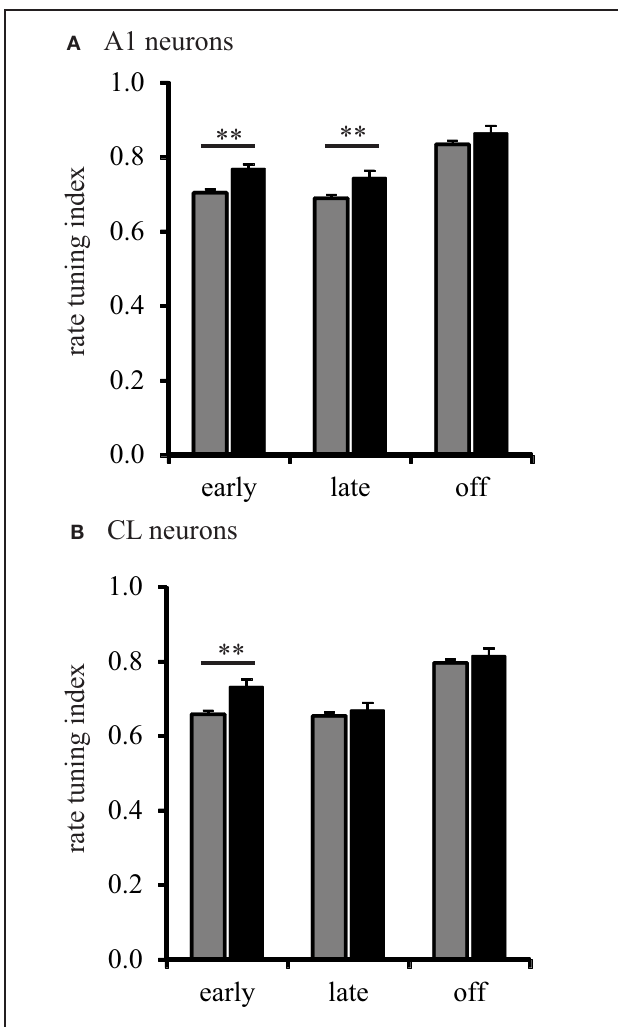
FIGURE 5 | Population spatial tuning index during different response periods. Panel (A) shows the RTI during the early, late, and off periods in A1 of young (gray) and aged (black) monkeys. There were differences found except during the off period. Panel (B) shows the results from CL neurons. Here, aged monkeys were more broadly spatial tuned during the early period ( ∗∗ p < 0 . 01).